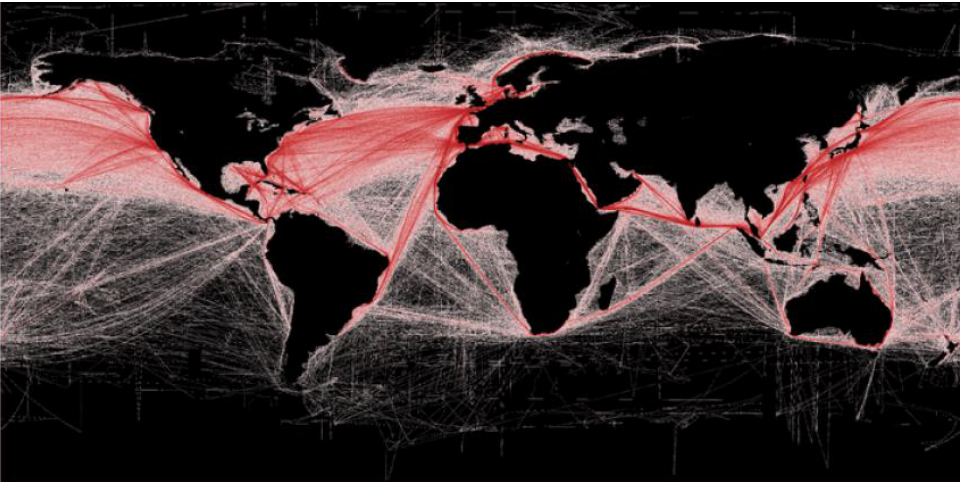
Figure 1. Relative global commercial shipping density based on ~11% of merchant ships > 1000 gross tonnage. Reprinted with permission from ref. [6]. Copyright © 2019 Elsevier Ltd. All rights reserved.